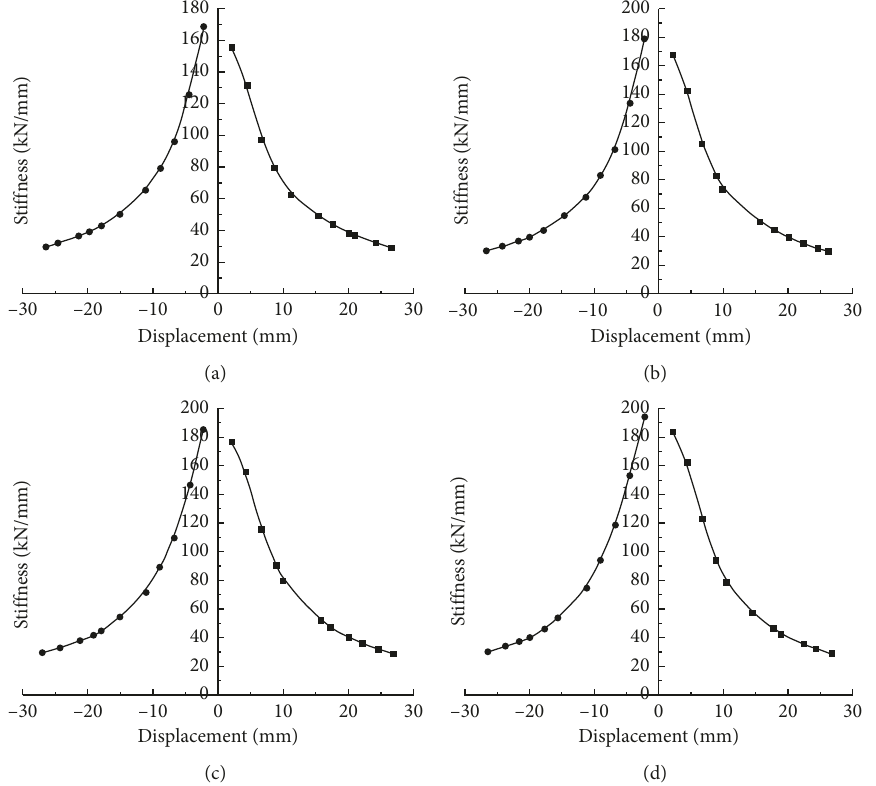
Figure 10: Stiffness degradation curves of frames with various concrete strengths. (a) K-1. (b) K-2. (c) K-3. (d)